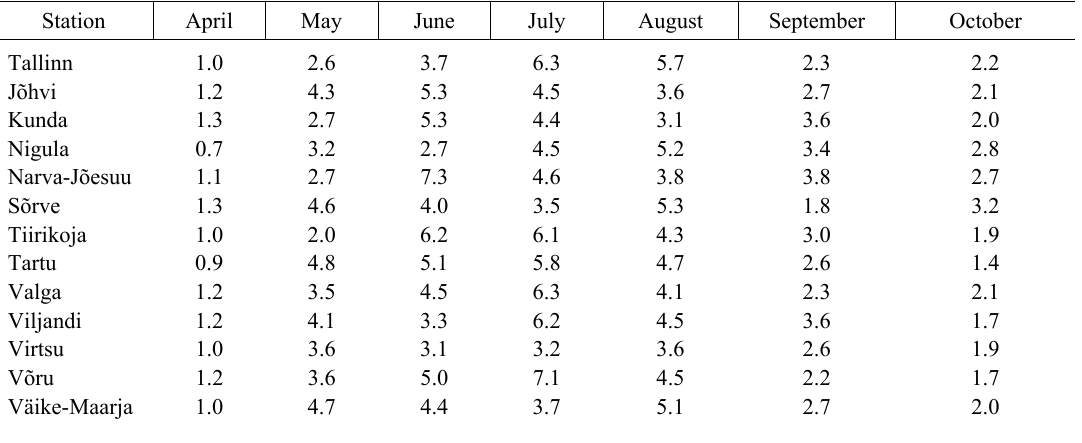
Table 1. Monthly mean daily precipitation amplitudes at the stations during